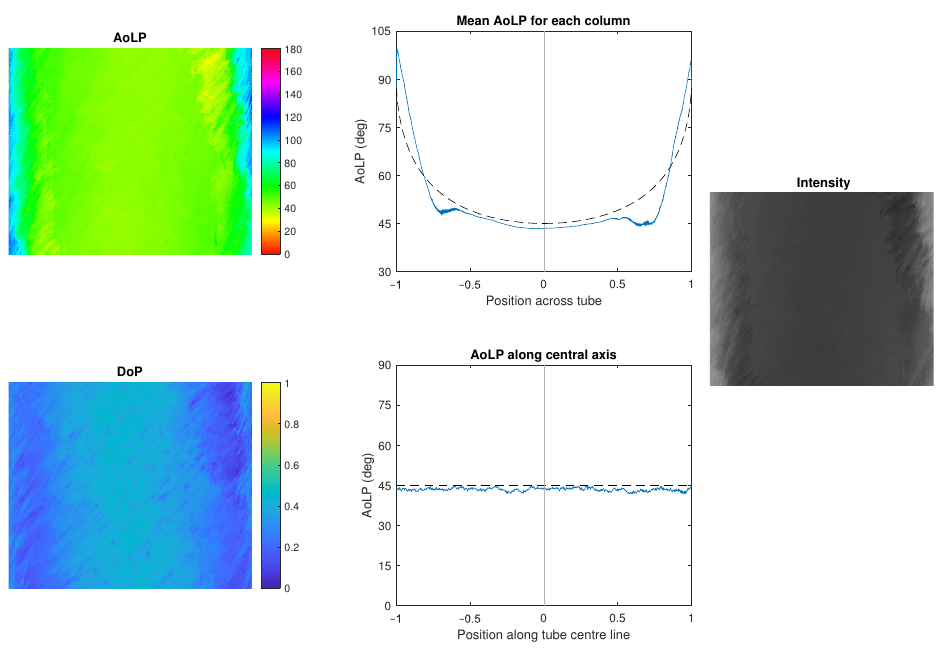
Figure 27. Recovered data for the UD dry tube under dome illumination in a similar format to the case of Figure 23.